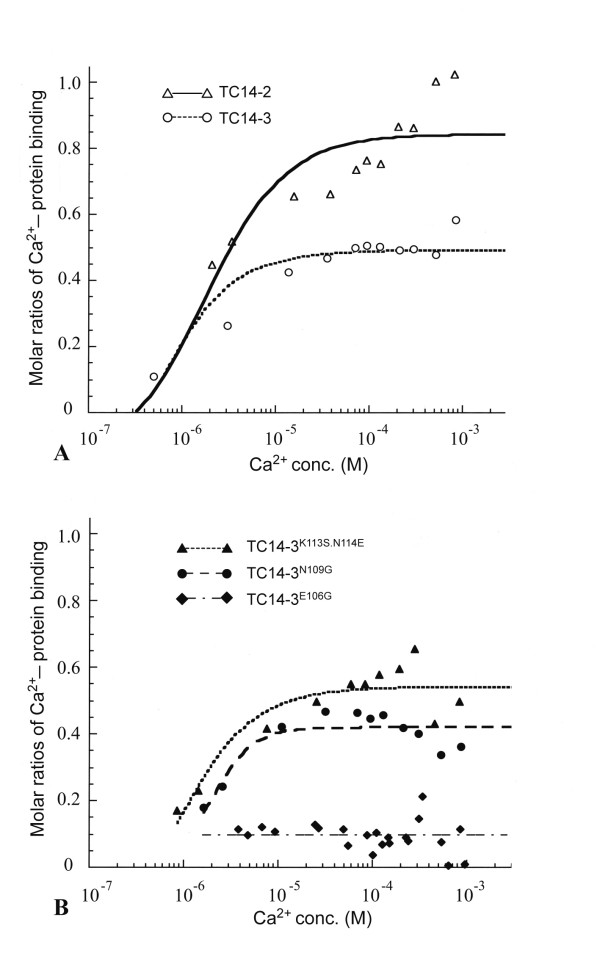
Calcium-binding kinetics of wild-type and mutant TC14s. (A)Wild type TC14-2 and TC14-3. Note that the Ca2+-binding affinity of TC14-3 is lower than that of TC14-2. (B)TC14-3E106G, TC14-3N109G, and TC14-3K113S.N114E. TC14-3N109G showed lower Ca2+-binding affinity than wild-type TC14-3 and TC14-3K113S.N114G showed the higher affinity to some extent.